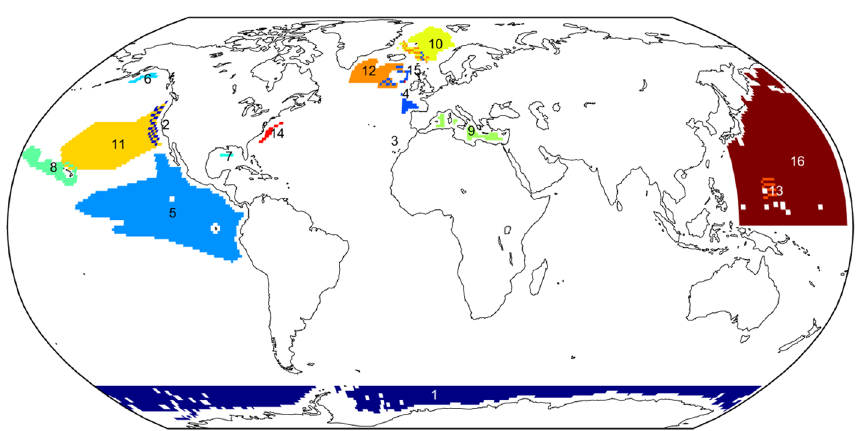
Figure 1. Sperm whale surveys used to produce global population estimates. Numbers by each colour reference surveys listed in Table 1. Where surveys overlap the colours are pixelated. Unsurveyed waters, waters less than 1000 m deep and land are uncoloured. Map created using MATLAB2021b